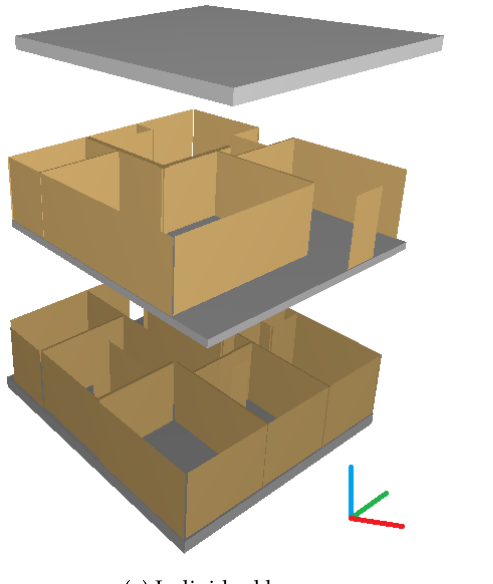
Table 4. Deviations between control points selected in floor plans created manually and automatically.